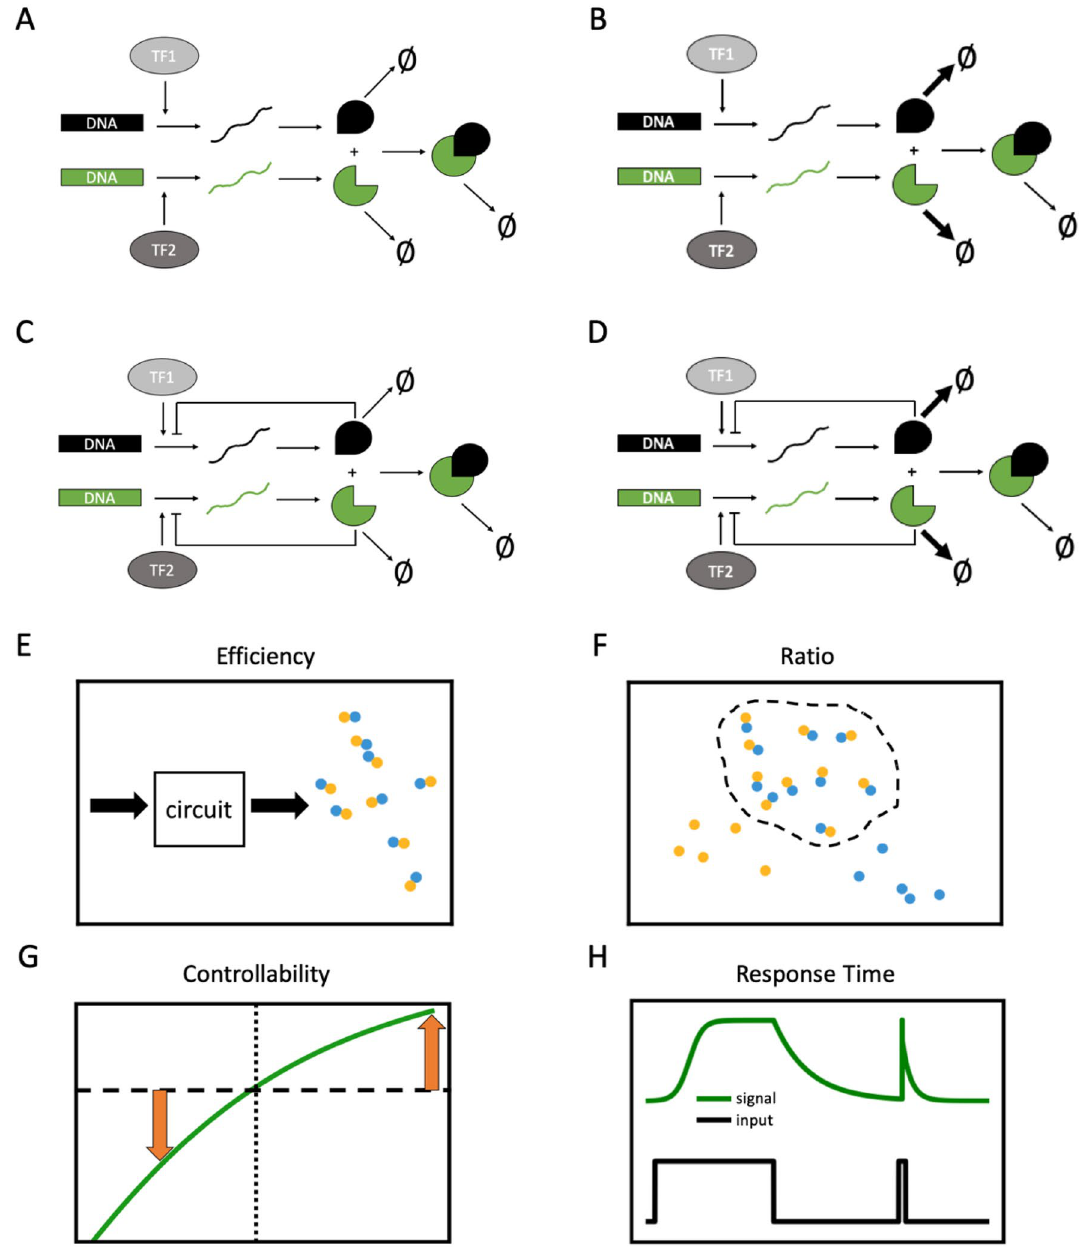
Figure 3. Schematics of our model circuits and characteristics of a protein complex formation system. ( A – D ) Diagrams of the four assessed circuits. ( A ) Circuit 1 (open loop without cooperative stability). ( B ) Circuit 2 (open loop with cooperative stability). ( C ) Circuit 3 (negative feedback loops without cooperative stability). ( D ) Circuit 4 (negative feedback loops with cooperative stability). ( E – H ) Schematics of the characteristics of a protein complex formation system. ( E – G ) Equilibrium properties, i.e. ( E ) efficiency, ( F ) dimer ratio, and ( G ) controllability, of a system at steady-state. ( H ) Dynamic behaviors of the system, i.e., response time to upward regulation, response time to downward regulation, and recovery time after a shot